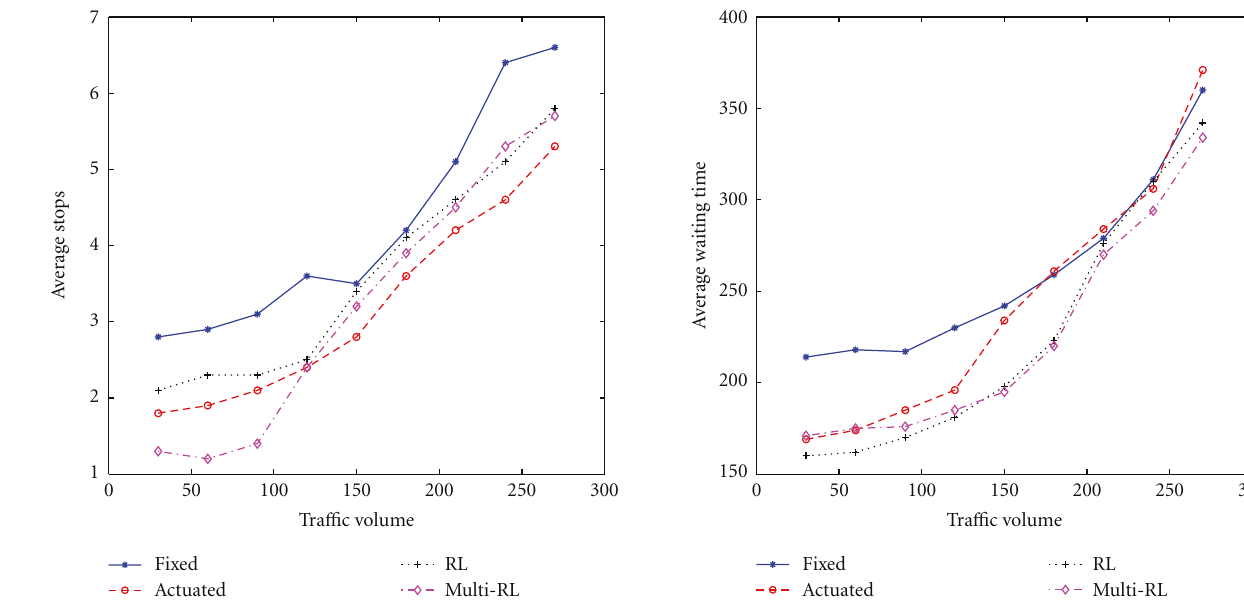
Figure 5: Control e ff ects comparison estimated by average waiting time.